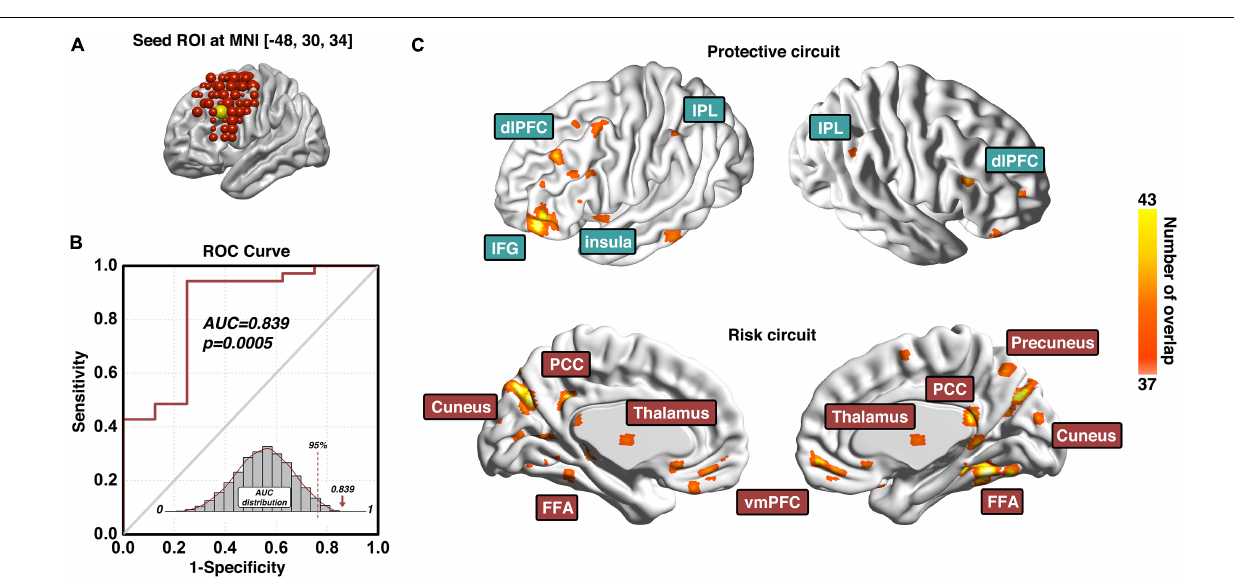
FIGURE 3 | Predictive ROI location, model prediction accuracy, and associated functional circuits. Adapted from Zhai et al. (2021), panel (A) shows the location and MNI coordinates of the predictive dlPFC ROI; the prediction accuracy measured with the area-under-the-curve (AUC) of the receiver-operating-characteristic (ROC) curve and its corresponding statistical significance is demonstrated in panel (B) ; and the functional circuits associated with this dlPFC ROI that were used to generate the composite indexP and indexR for subsequent early relapse prediction is recapped in panel (C) . ROI, region-of-interest; ROC, Receiver-Operating-Characteristics; AUC, area-under-the-curve; dlPFC, dorsolateral prefrontal cortex; IPL, inferior parietal lobule; IFG, inferior frontal gyrus; PCC, posterior cingulate cortex; FFA, fusiform face area; vmPFC, ventromedial prefrontal